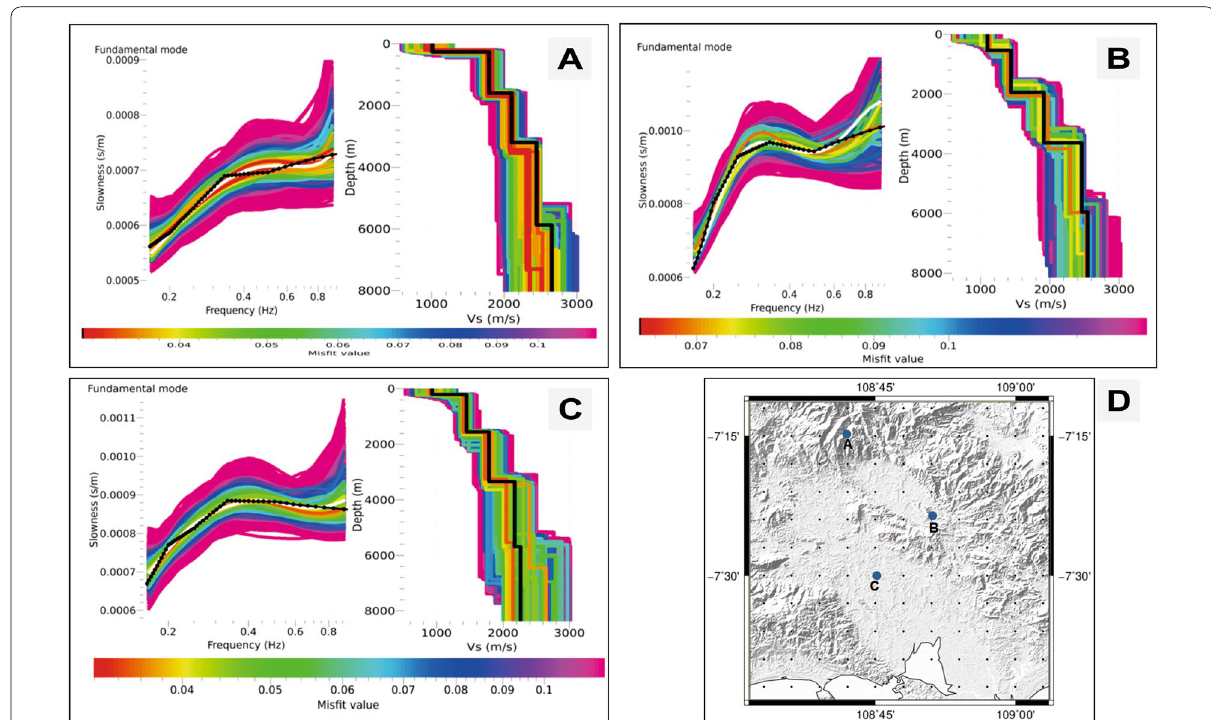
Fig. 5 A–C Three examples of dispersion curve inversions at three different locations; D coordinates of three examples (denoted by blue dots) of the application of dispersion curve inversion in the study area. Small, gray dots denote the 121 grid points of the dispersion curve